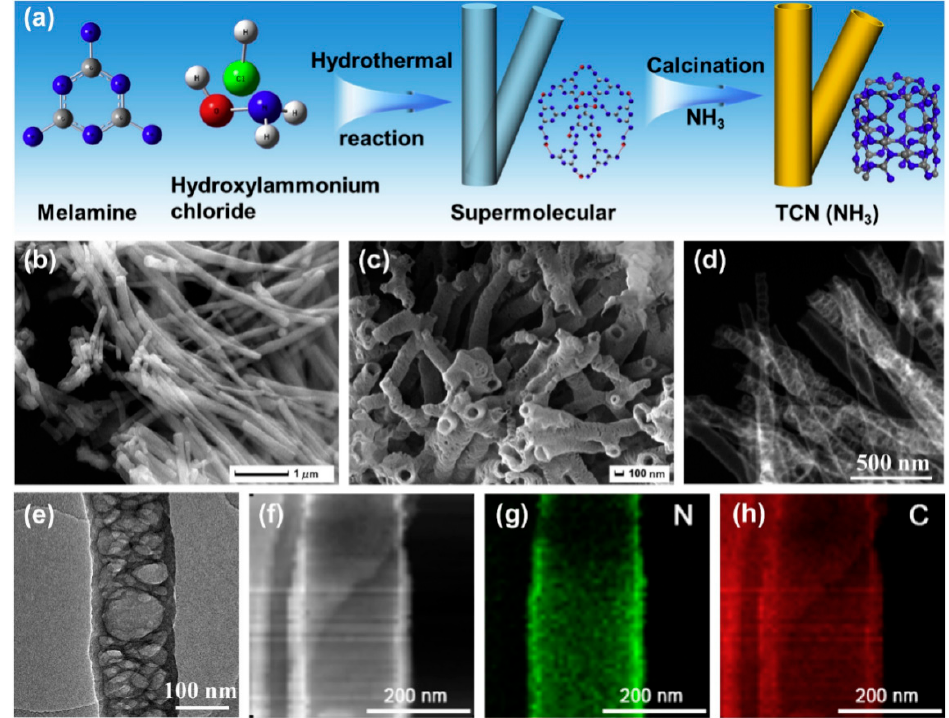
Figure 3. Formation and characterization of g-C 3 N 4 /NH 3 . Schematic illustration of the synthetic process ( a ), SEM images ( b , c ), TEM images ( d , e ), scanning tunneling electron microscopy (STEM) image ( f ), and energy dispersive X-ray (EDX) maps of the g-C 3 N 4 /NH 3 nanotubes (TCN (NH 3 )) ( g , h ). Reprinted from [62], Copyright (2019), with permission from Elsevier.